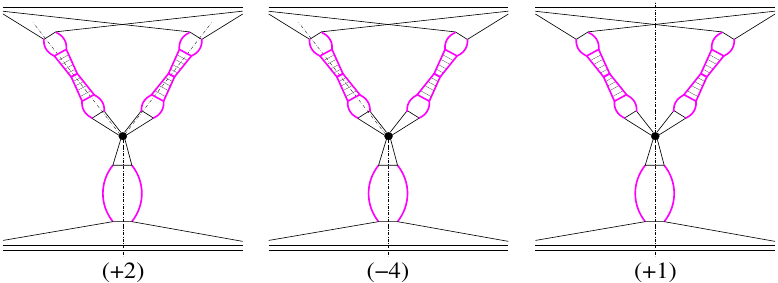
Figure 6. Schematic diagrams for the contributions of the “soft parton splitting” mechanism to double-dijet production ( left ), screening correction to single-dijet production ( middle ), and high mass diffraction of the target proton ( right ); relative weights of the contributions are shown below the graphs. Perturbative parton cascades are represented by the ladders and soft parton evolution—by the “blobs”; the triple-Pomeron interaction vertex is shown by the small black circle. The vertical dashed-dotted lines indicate the position of the cut